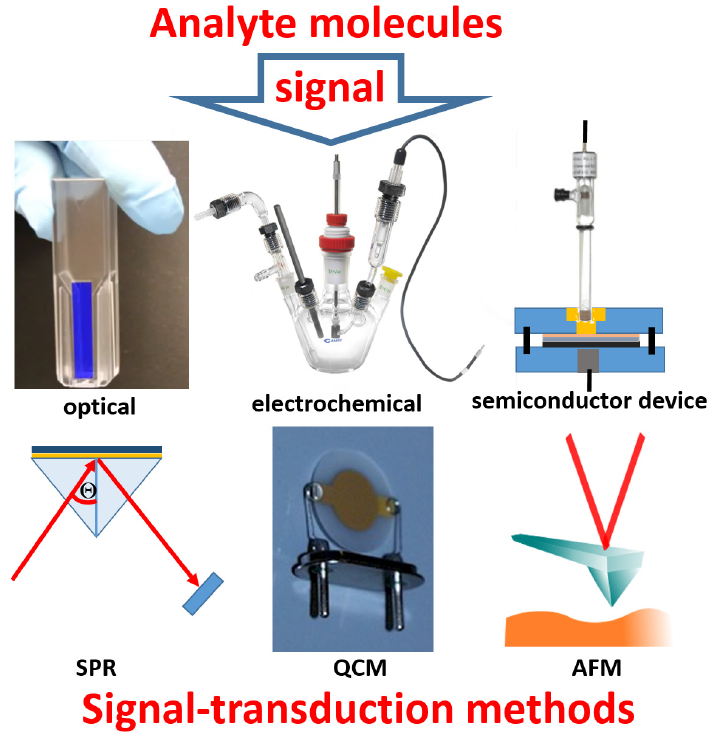
Figure 2. Transduction methods for converting analyte molecule signals to an electronic output: ( i ) optical measurements based on absorbance or fluorescence spectroscopy, ( ii ) various electrochemi ‐ cal measurements including amperometry, potentiometry, impedance spectroscopy, etc., ( iii ) semi ‐ conductor measurements, e.g., field ‐ effect transistor signal transduction, using current, potential or capacitance measurements, ( iv ) surface plasmon resonance (SPR) measurements, ( v ) microgravimet ‐ ric measurements using quartz crystal microbalance (QCM), and ( vi ) nanotechnological methods, e.g., atomic force microscope (AFM) measurements.